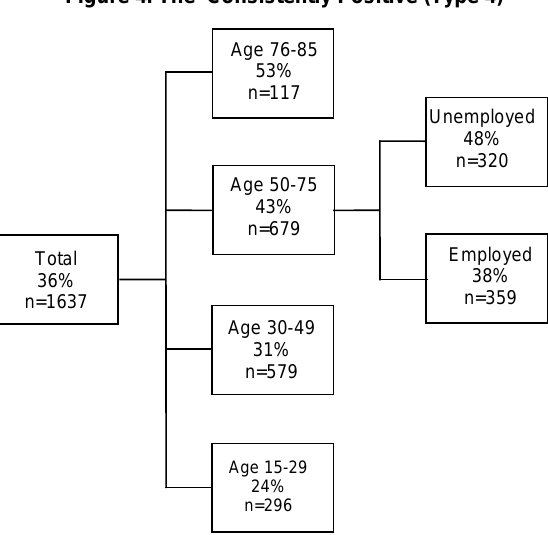
Figure 4. The Consistently Positive (Type